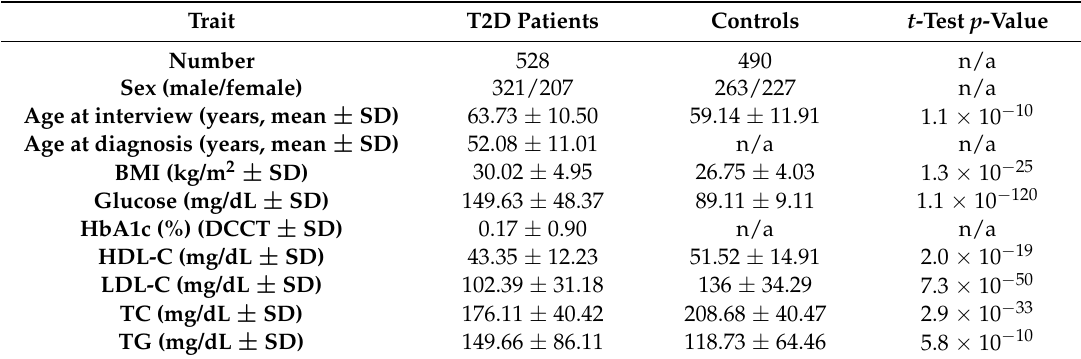
Table 1. Summary of the main phenotypic characteristics of the study